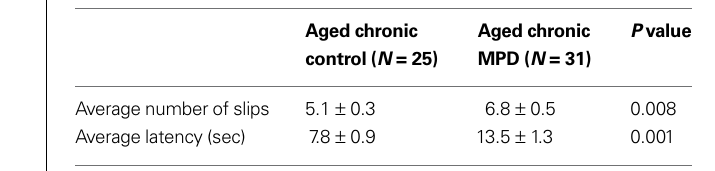
Table 5 | Challenging beam performance of chronic aged (6–10 months old) MPD a